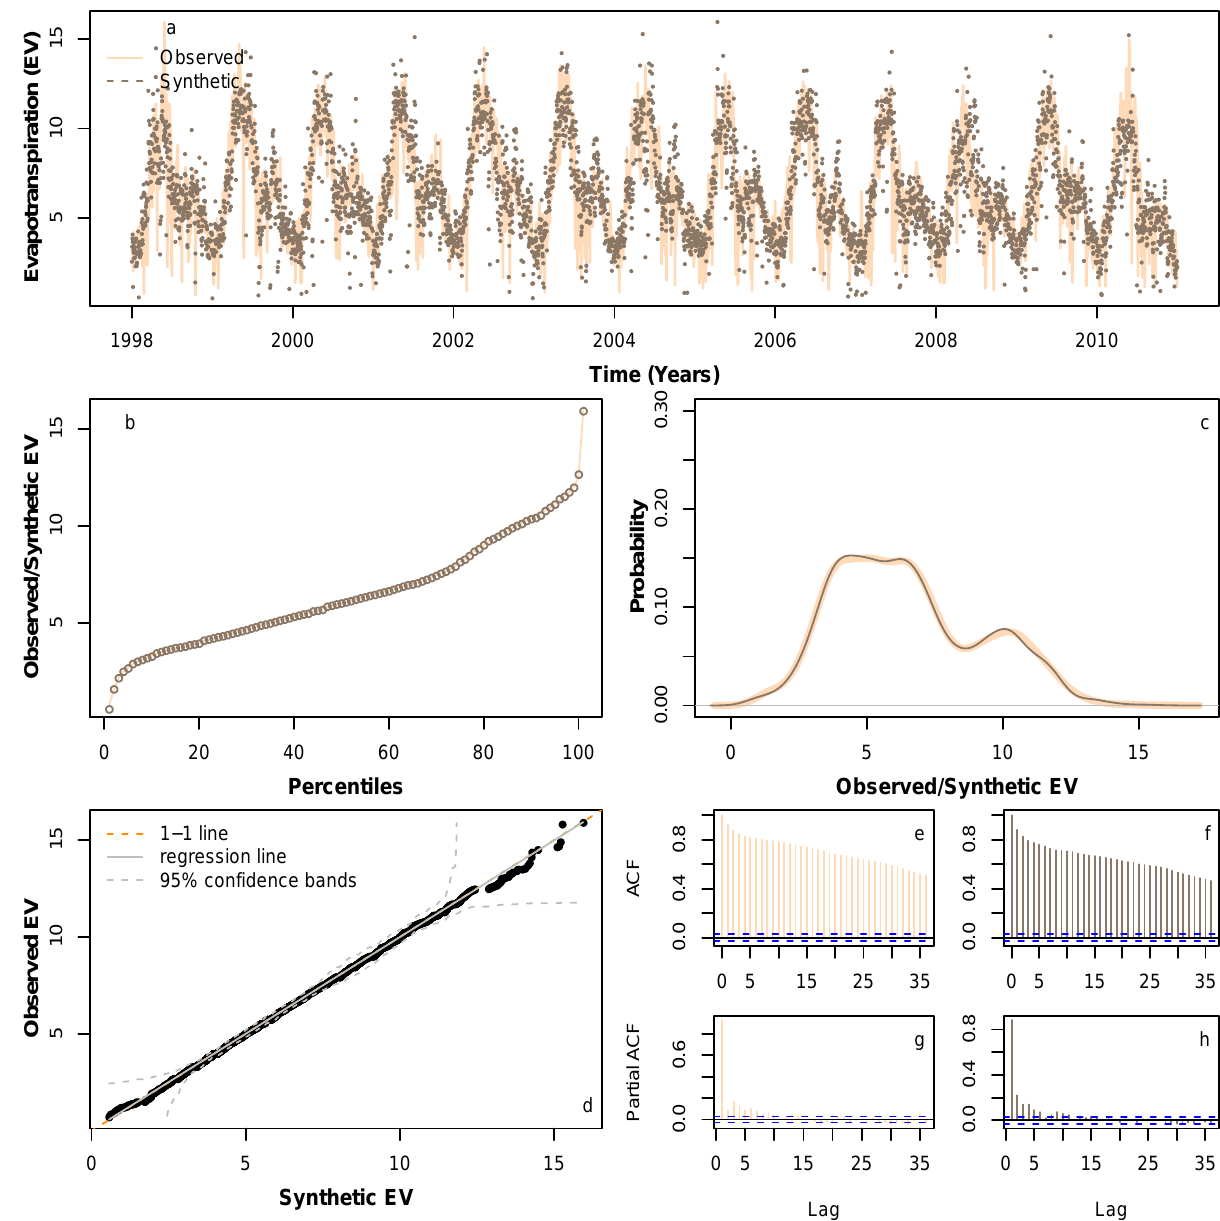
Figure 6. Comparison of various statistical characteristics of a sample synthetic EV time series during the period 1998–2010 (dotted brown lines), based on learning EV pattern from 1998 to 2010, with observed EV 1998–2010 time series (solid peach lines): Comparing ( a ) realisation; ( b ) percentiles; ( c ) probability density distribution; ( d ) QQ-plot; ( e ) ACF for observed; ( f ) ACF for a sample synthetic series; ( g ) PACF for observed; and ( h ) PACF for a sample synthetic